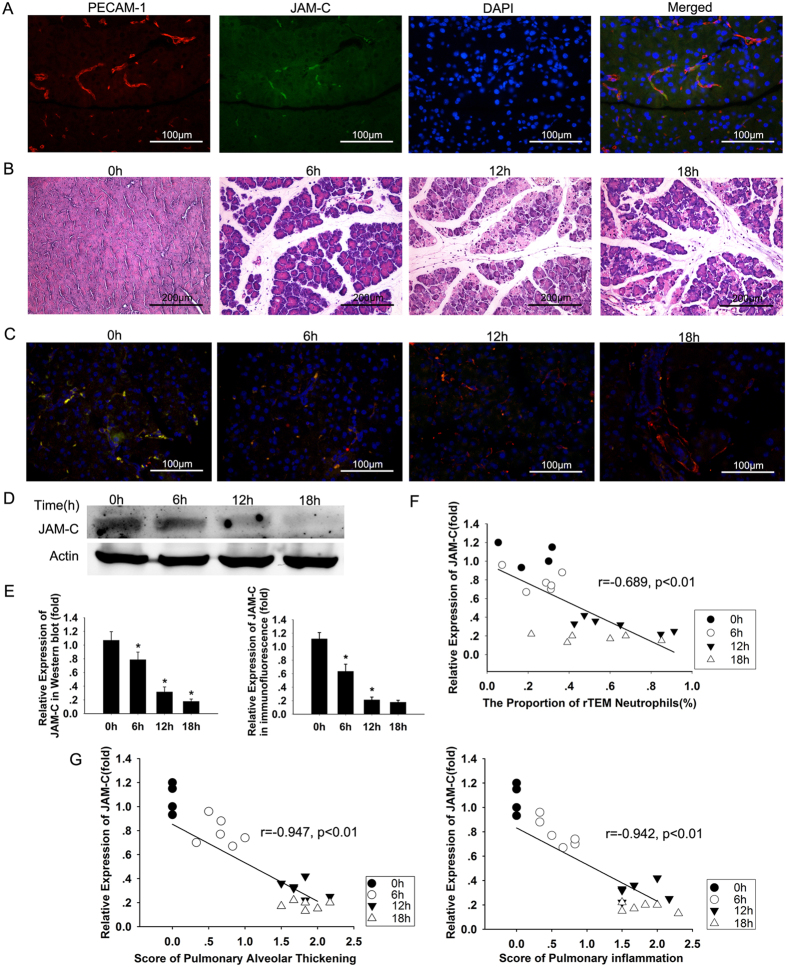
Expression of JAM-C in pancreas and its relationship between reverse-migrated neutrophils and lung injury during caerulein and LPS-induced pancreatitis.(A) Double immunofluorescent staining for PECAM-1 (red) and JAM-C (green) in normal murine pancreas. DAPI (blue) was used to counterstain the nuclei. JAM-C is expressed in blood vessels in the murine pancreas. (B) Representative micrographs of the pancreas of control mice and mice with experimental pancreatitis at 0 h, 6 h, 12 h and 18 h after the first caerulein injection are shown. (C,D) The level of JAM-C expression is downregulated at both 12 h and 18 h after the first caerulein injection. JAM-C protein expression (green) with a co-staining for PECAM-1 (red) is shown on immunofluorescence (C) and a western blot of total pancreatic lysates (D). (E) A quantitative analysis of the western blot (left) and immunofluorescence (right) showed JAM-C was down-regulated in a time dependent manner (*p < 0.01 compared with the previous time point). (F) A decreased level of JAM-C correlated with increased numbers of rTEM neutrophils in the peripheral blood (r = −0.689, p < 0.01). (G) A decreased level of JAM-C correlated with lung injury (alveolar thickening: r = −0.947, p < 0.01; inflammation: r = −0.942, p < 0.01). n = 6 at each time point. Original magnification: ×400 for immunofluorescence, ×200 for H&E sections. Mice were sacrificed 0 h, 6 h, 12 h and 18 h after the first caerulein injection.